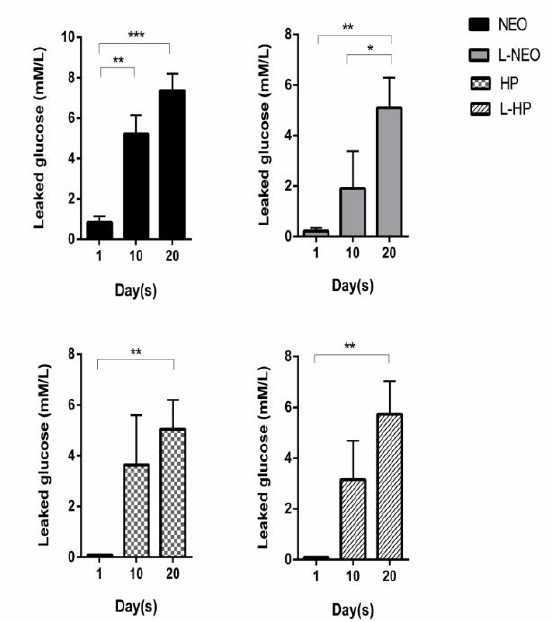
Figure 7. Glucose leakage per experimental group for 20 days. Results are expressed as mean values + SEM. Two-way ANOVA followed by Tukey’ s post-hoc test was used for statistical analysis to compare the results per group at 1st, 10th, and 20th days (***, p < 0.001; **, p < 0.01; *, p < 0.05; no asterisks, not significantly di ff